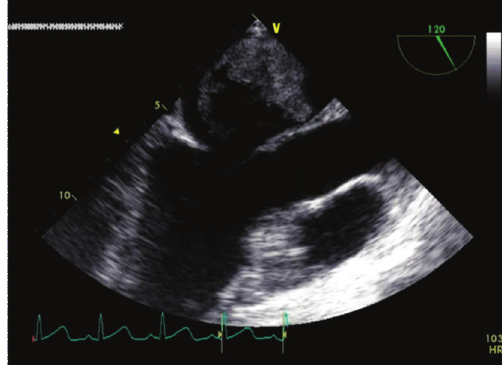
Figure 2: Transesophageal echocardiography showing left atrial myxoma.